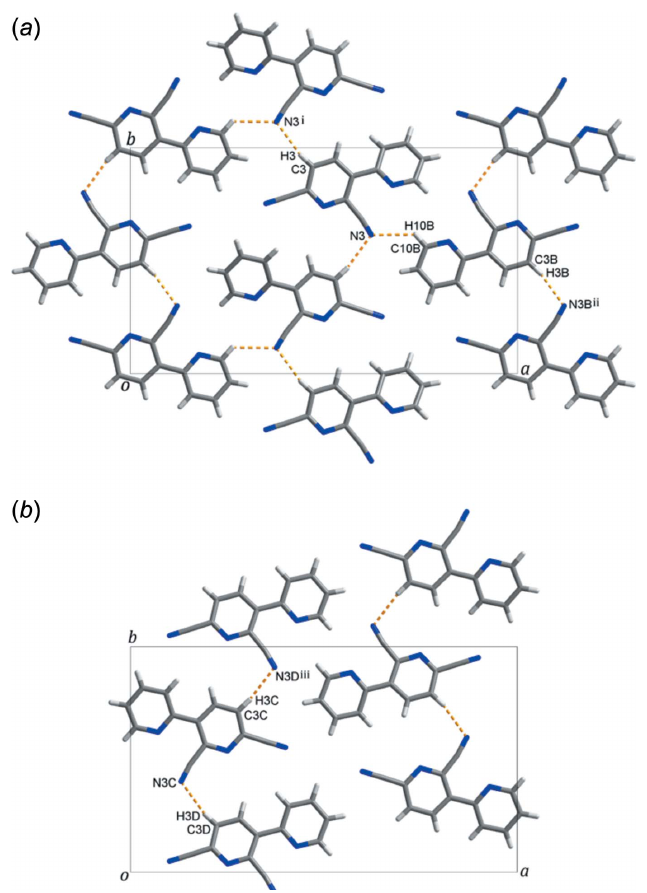
Figure 3 ( a ) View along the c axis of the layer formed by C—H (cid:2)(cid:2)(cid:2) N hydrogen bonds between molecules A and B; ( b ) view along the c axis of the chains formed by C—H (cid:2)(cid:2)(cid:2) N hydrogen bonds between molecules C and D [symmetry codes: (i) (cid:5) x + 1, y + 1 y + 1, z ; colour codes: grey = carbon, blue = nitrogen and white = hydrogen].